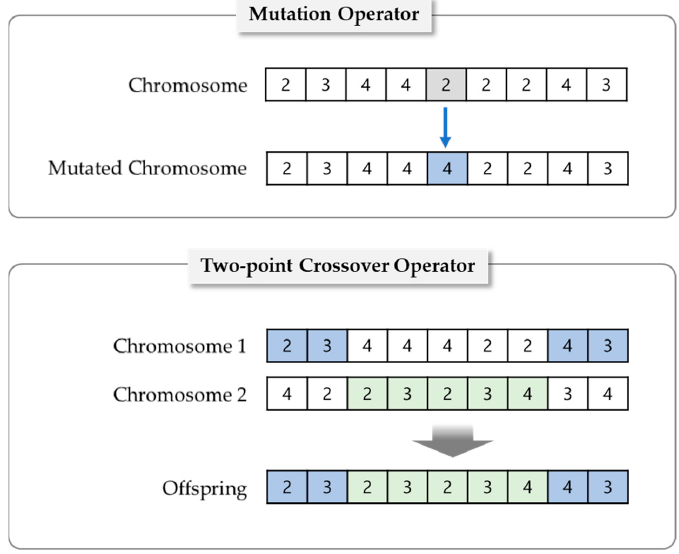
Figure 4. Illustration of mutation and crossover operations.